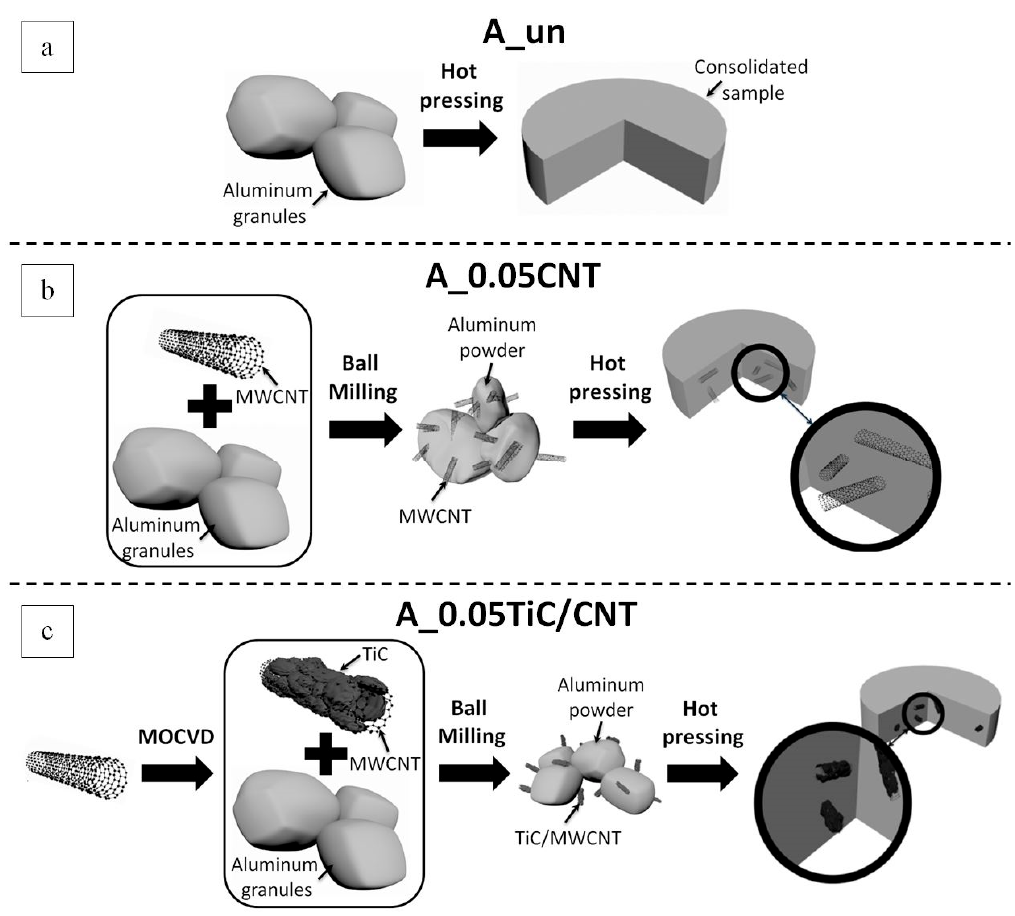
Figure 1. Schematic representation of the synthesis of bulk materials: (a) producing consolidated samples (A_un) from the initial aluminum granules without ball milling; (b) producing consolidated samples of aluminum matrix nanocomposites (A_0.05CNT) reinforced with carbon nanotubes without prior coating; (c) producing consolidated samples of aluminum matrix nanocomposites (A_0.05TiC/CNT) reinforced with carbon nanotubes and coated with titanium carbide nanoparticles.